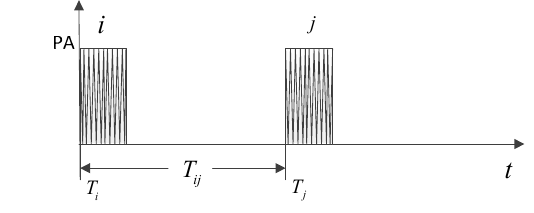
Figure 2. Sketch map of signal reconstruction.